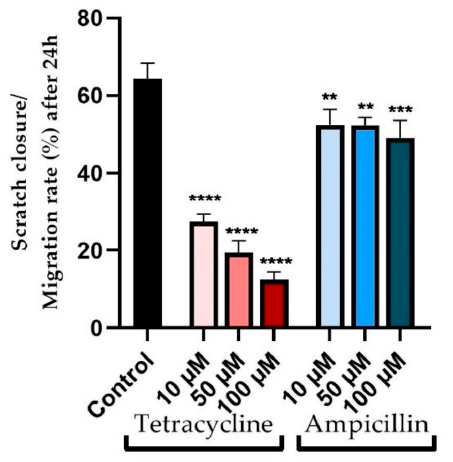
Figure 4. In vitro scratch wound healing image of the Detroit-562. The images were taken at the beginning of the experiment (T0) and after 24 h of stimulation (T24). The pictures were taken at a magnification 10×, and the scale bar indicates 1000 μ m.